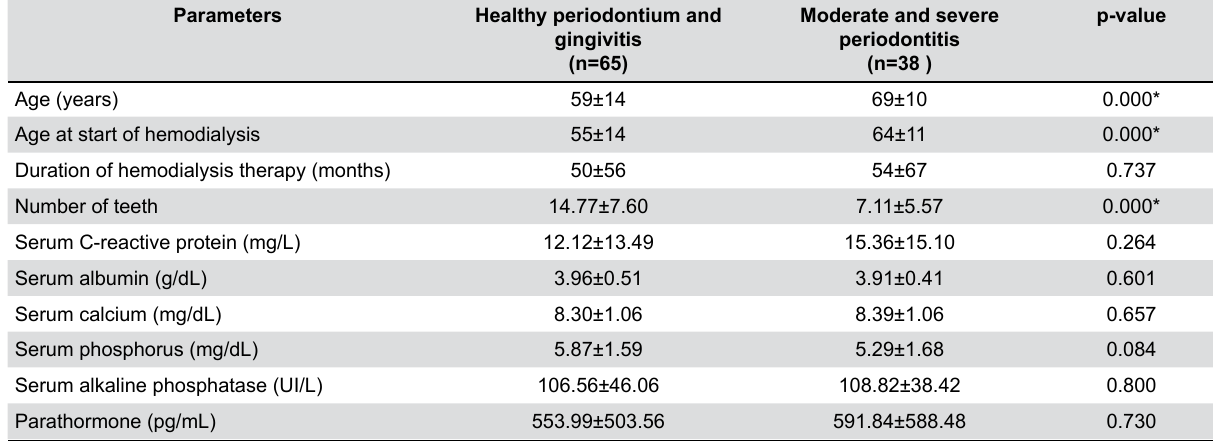
Table 3- Demographic, clinical and laboratory characteristics in dentate groups according to the periodontal status; quantitative parameters